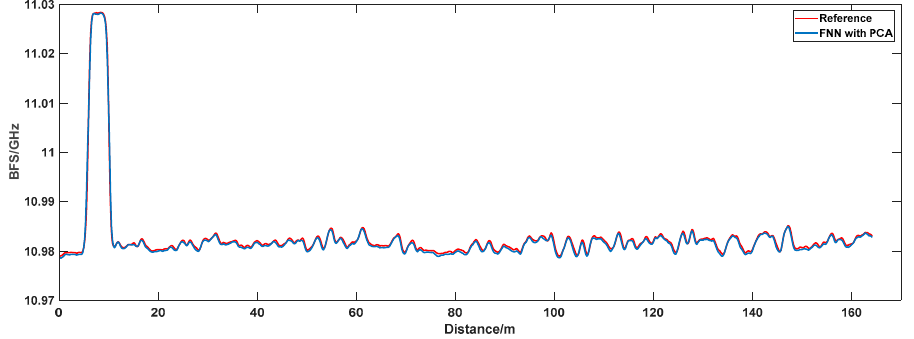
Figure 11. There are estimated BFSs at the beginning of the sensing fiber, where the 5-m hotspot of 76 °C is placed. The red line represents the results of LCF measuring BFS, as a reference for real BFS.